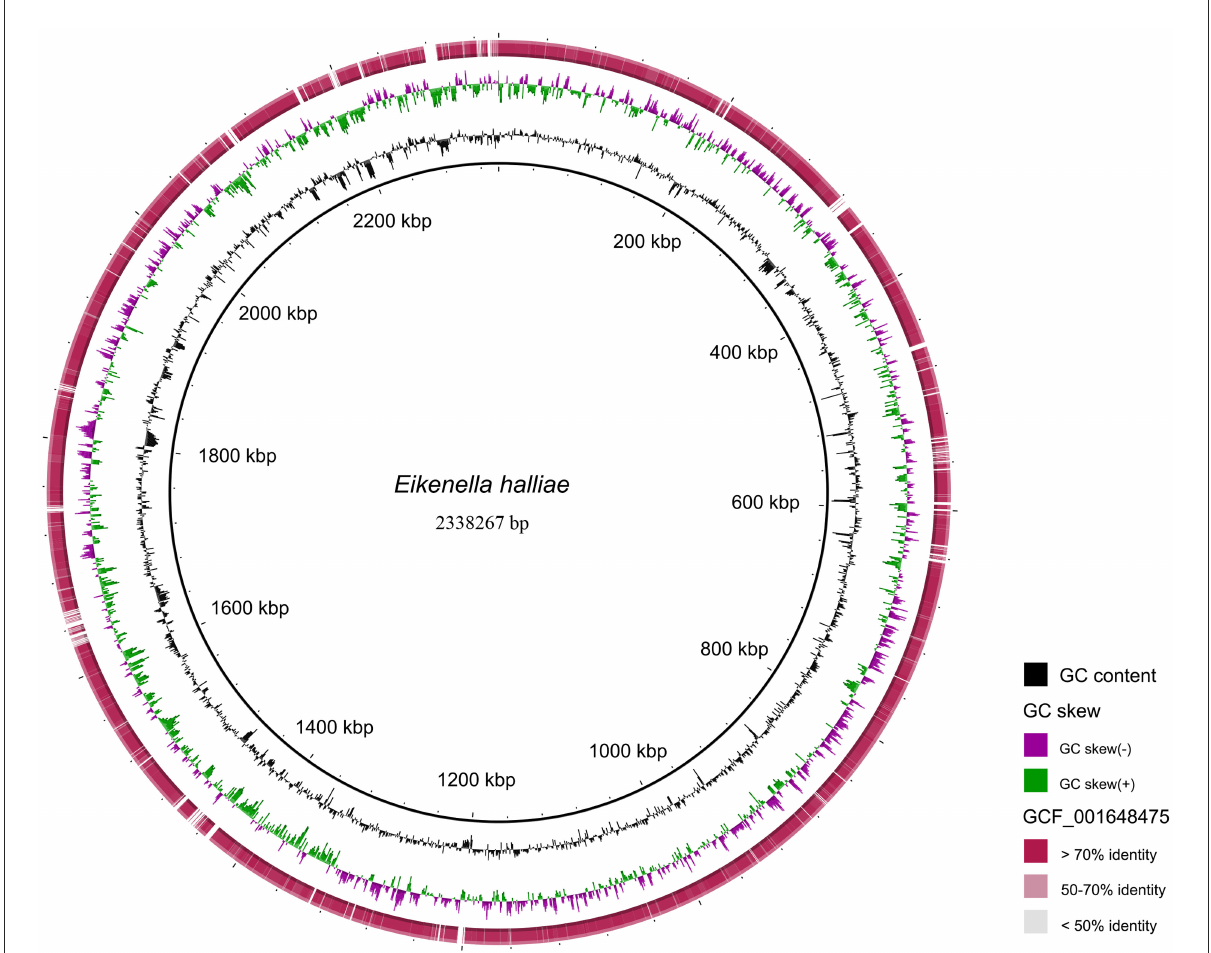
FIGURE4 The detected NGS results of the isolate mapped to the reference genome of Eikenella halliae (GCF_001648475.1). Reads with > 70% identity to the reference genome of E. halliae are marked in dark red; Reads with 50 ∼ 70% identity to the reference genome of E. halliae are marked in light red; Reads with < 50% identity to the reference genome of E. halliae are marked in